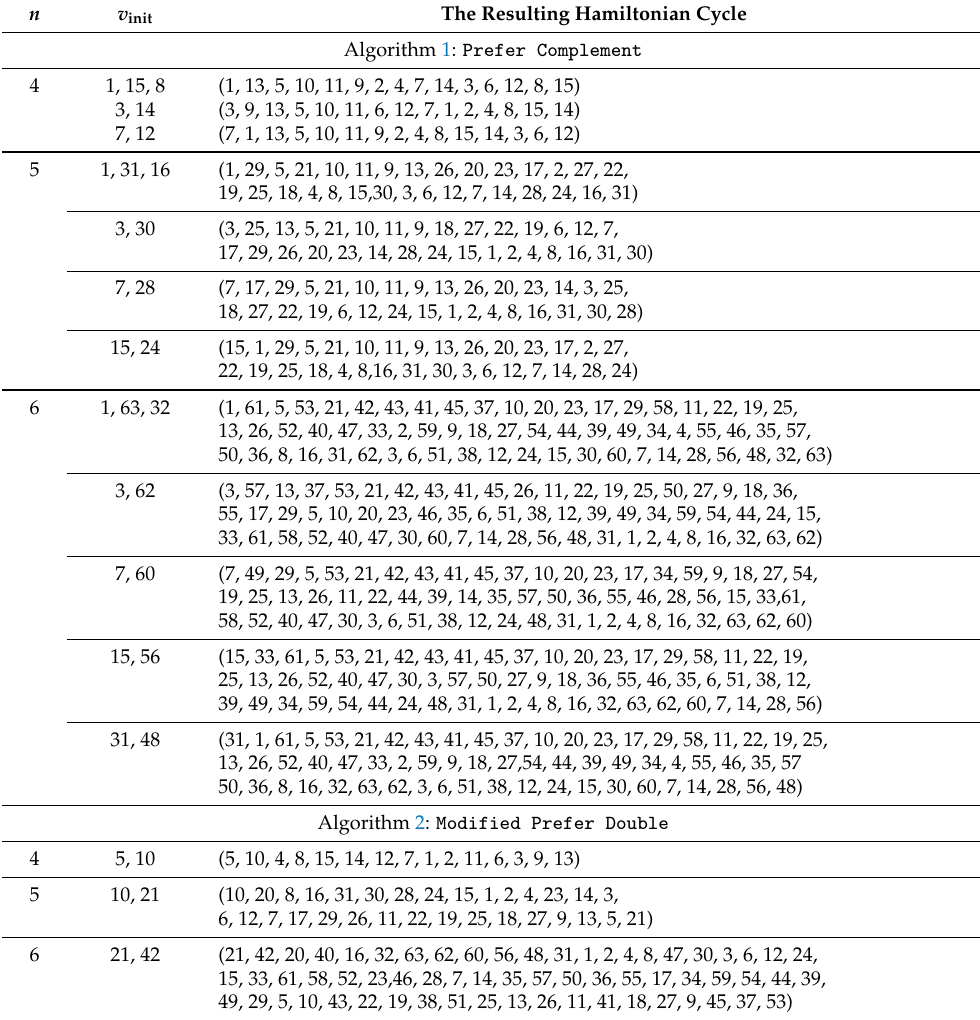
Algorithm 2: Modified Prefer